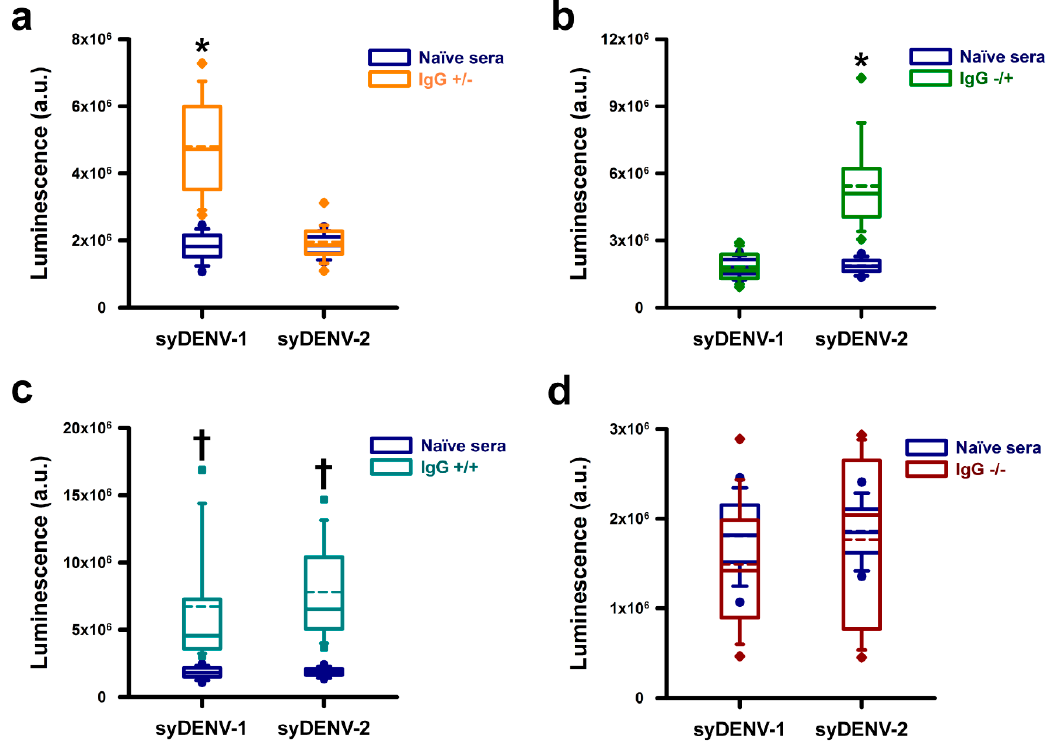
Figure 4. Immunoreactivity of DENV NS1+ positive sera against the synthDENVElope proteins. The IgG-antibodies present in NS1+ sera reacted against the syDENV proteins and their signals could be separated into distinct groups. The first, small group of NS1+ sera showed higher, statistically significant luminescence levels when reacting against the syDENV-1 protein than the syDENV-2 protein. These sera also showed higher, statistically significant signals than those generated by a panel of naïve sera reacting against both synthetic proteins ( a ). A second, larger, group of NS1+ sera generated higher, statistically significant luminescence signals when reacting against the syDENV-2 protein than the signals generated by naïve sera reacting against both proteins ( b ). The third, and largest, group of NS1+ sera showed statistically significant higher luminescence levels against both synthDENVElope proteins than the signals generated by the naïve sera ( c ). A small fraction of NS1+ sera generated luminescence signals that were not different from those generated by the naïve sera ( d ). * denotes p < 0.01 vs. all other groups; † denotes p < 0.01 vs. naïve sera.